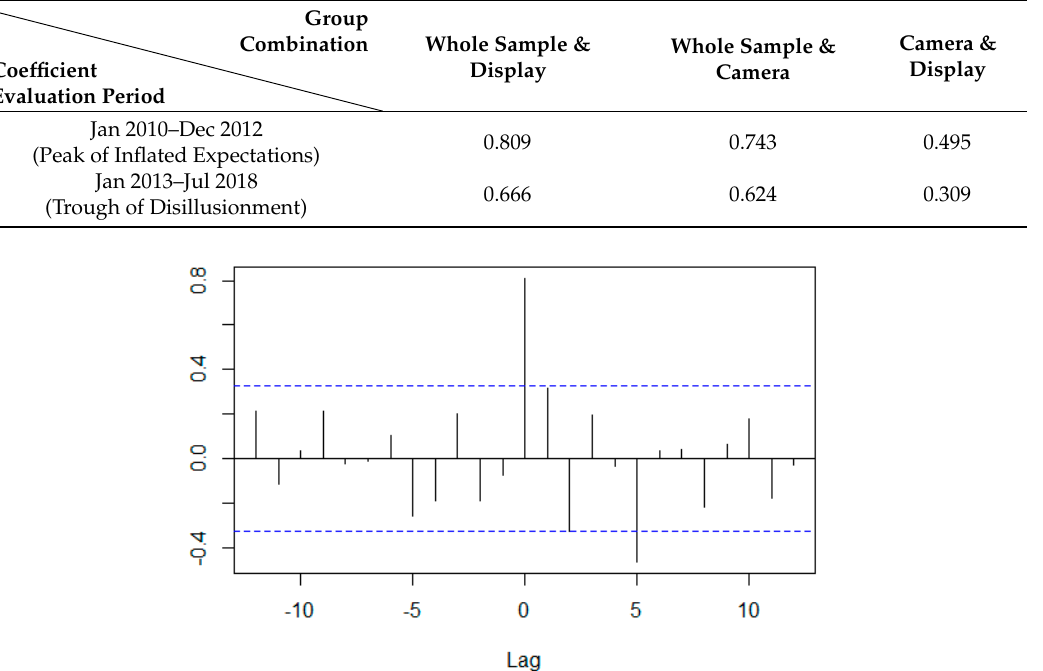
Figure 23. Cross-correlation coefficient between monthly rate of return of the whole sample group and monthly rate of return of the display group for Jan 2010–Dec 2012.